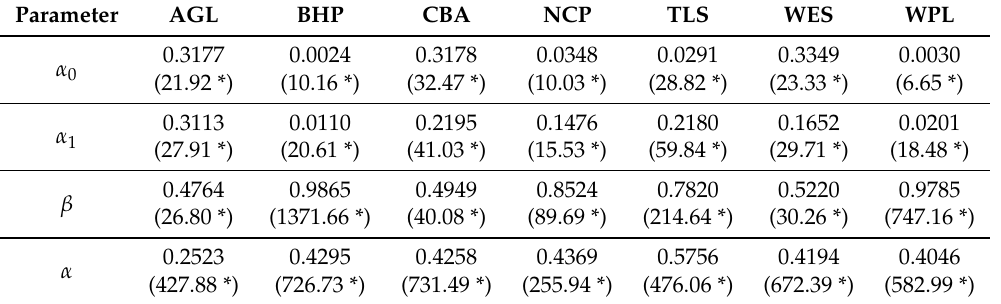
Table 2. The coefficient estimates of an ACD (1,1) model with Standardised Weibull errors fitted for the stocks. The conditional expected duration where x k is the adjusted duration. α is the shape parameter of the Weibull distribution.